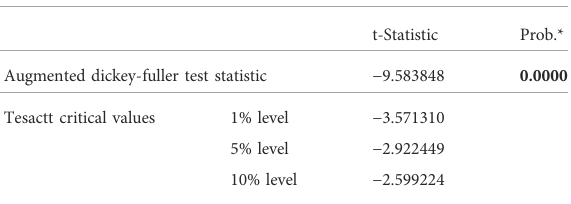
TABLE 3 The unit root test of second-order difference sequence.